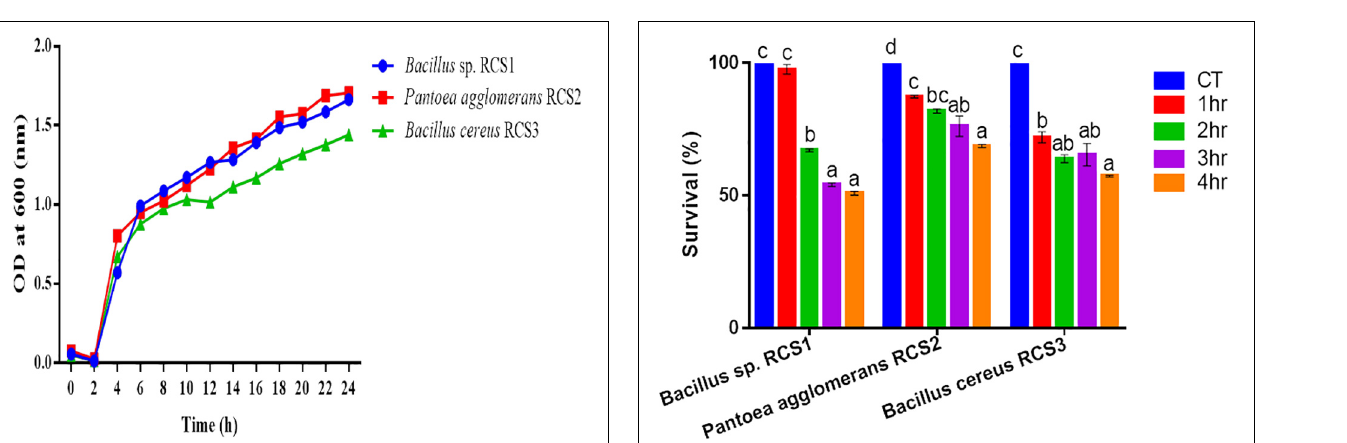
isolated bacteria to xylene, chloroform and ethyl acetate